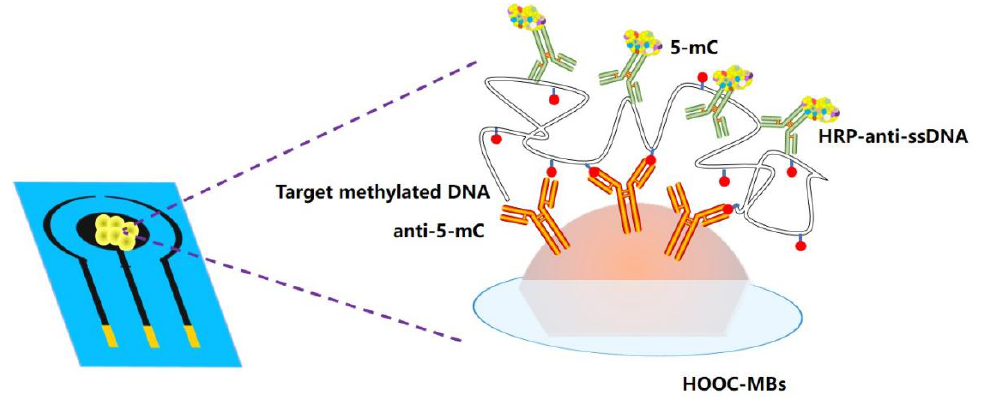
Figure 10. Schematic display of the immunosensor and ctDNA detection (Adapted with permission from Ref. [57]. 2019, Povedano et al.).